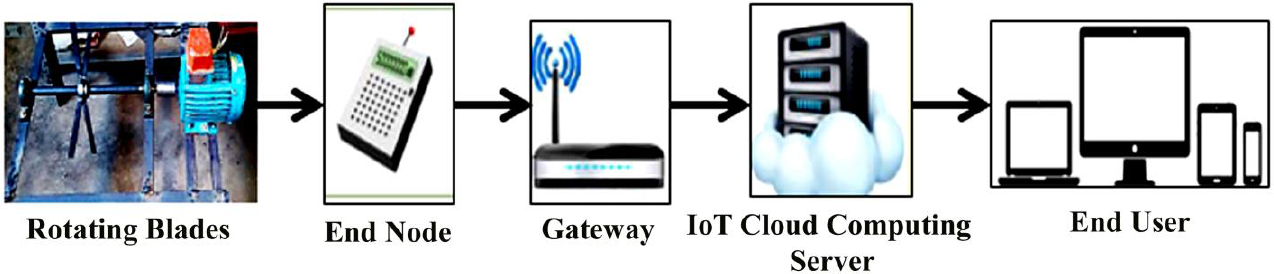
Figure 5. Schematic diagram of the online condition monitoring system.